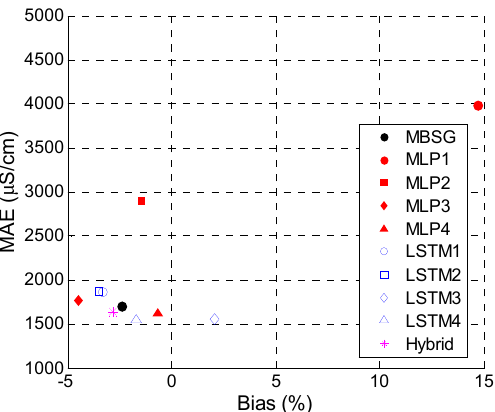
Figure 4. Percent bias (Bias; horizontal axis) and mean absolute error (MAE; vertical axis) between reference and simulated salinity at Martinez via different models during the entire evaluation period.